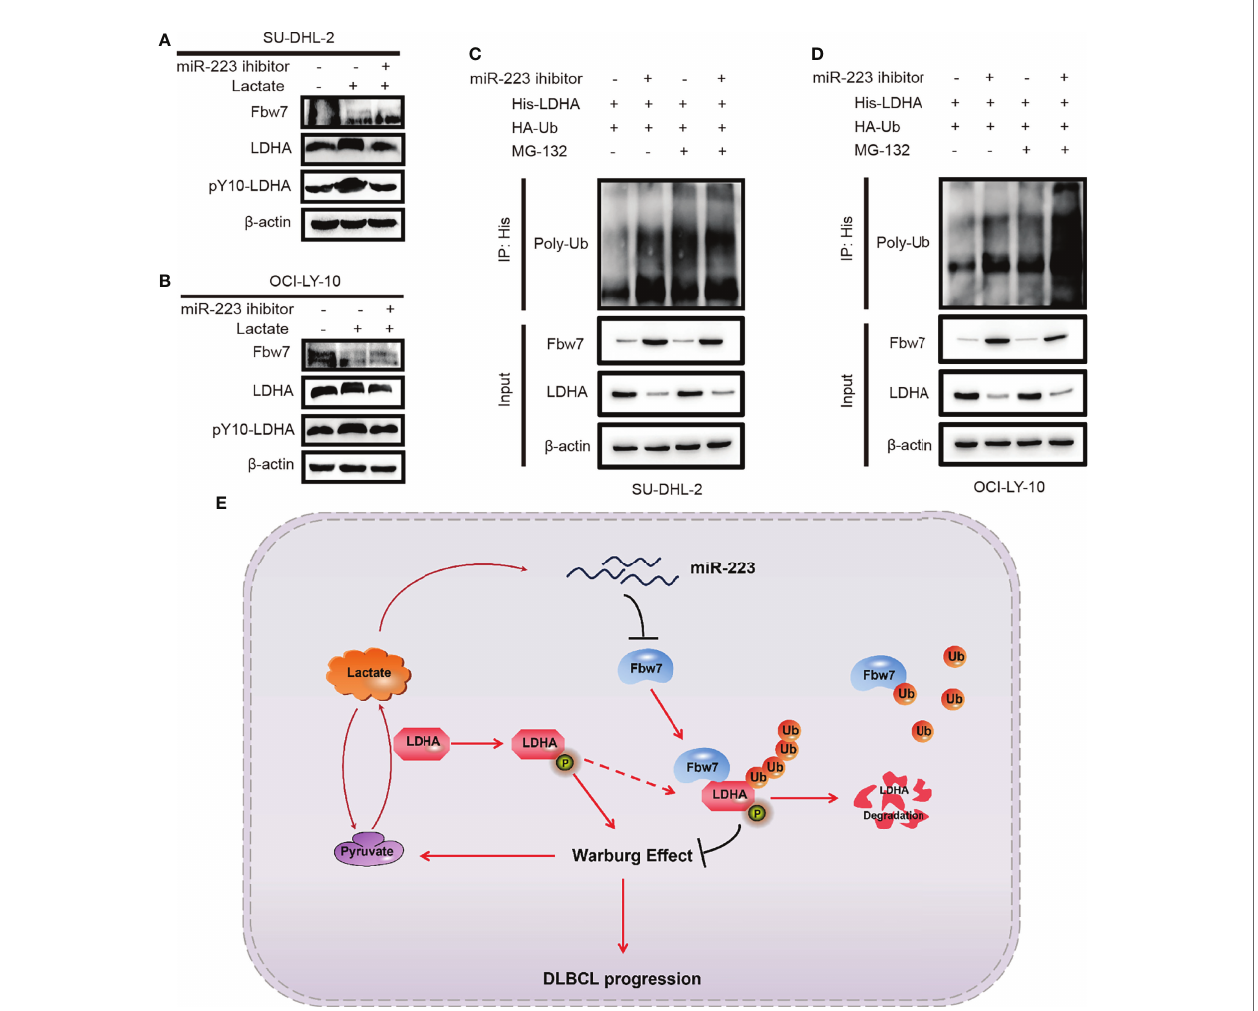
FIGURE 6 | Inverse correlation between Fbw7 and LDHA/lactate/miR-223 axis in ABC DLBCL. (A, B) the effects of lactate induction after miR-223 inhibitor was treated in SU-DHL-2 and OCI-LY-10 cells. The expressions of Fbw7, LDHA, pY10-LDHA were examined by western blotting. (C, D) His-LDHA and HA-ubiquitin were treated with miR-223 inhibitor in SU-DHL-2 and OCI-LY-10 cells. After treated with 10 mM MG132 for 6 hours, LDHA was co-immunoprecipitated with anti-His antibody, and the polyubiquitination status of LDHA was examined by immunoblotting. (E) schematic graph of potential mechanism of Fbw7 negatively regulates the positive feedback loop of the LDHA/lactate/miR-223 in ABC